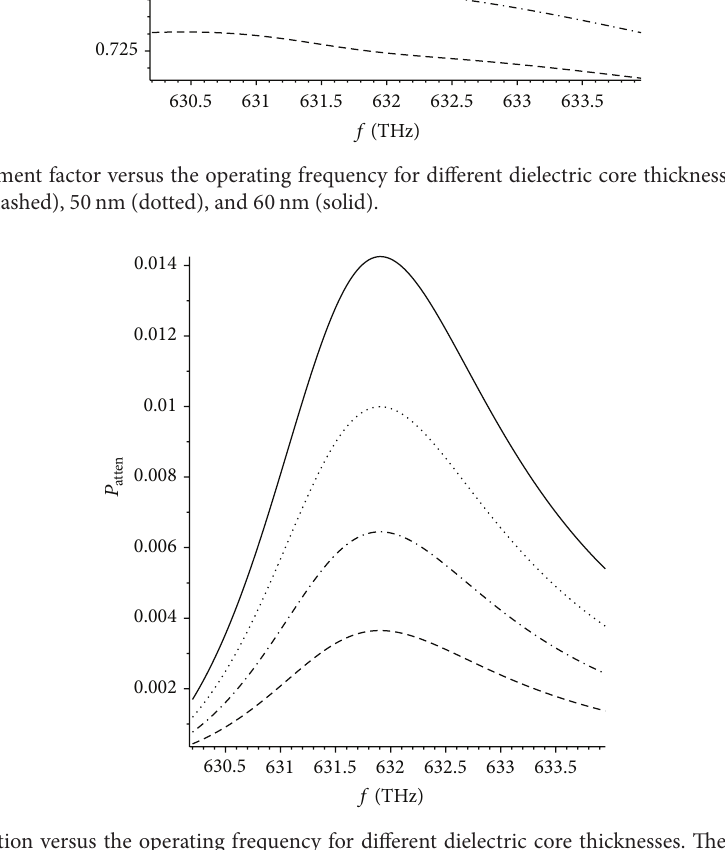
Figure 6: The power attenuation versus the operating frequency for different dielectric core thicknesses. The core thicknesses are 30nm (dashed), 40 nm (dot-dashed), 50 nm (dotted), and 60nm